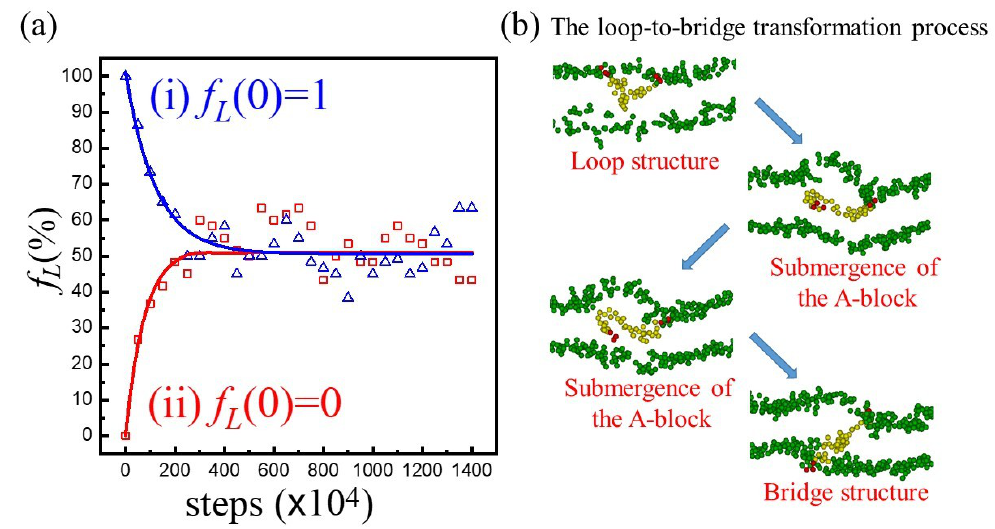
Figure 7. ( a ) The evolutions of f L with respect to simulation steps for A 3 B 36 A 3 in a hybrid membrane of ϕ p = 0.1. ( b ) The illustration of the loop-to-bridge transformation process. Green, red, and yellow beads represent lipid head, hydrophilic and hydrophobic beads of the copolymer, respectively.